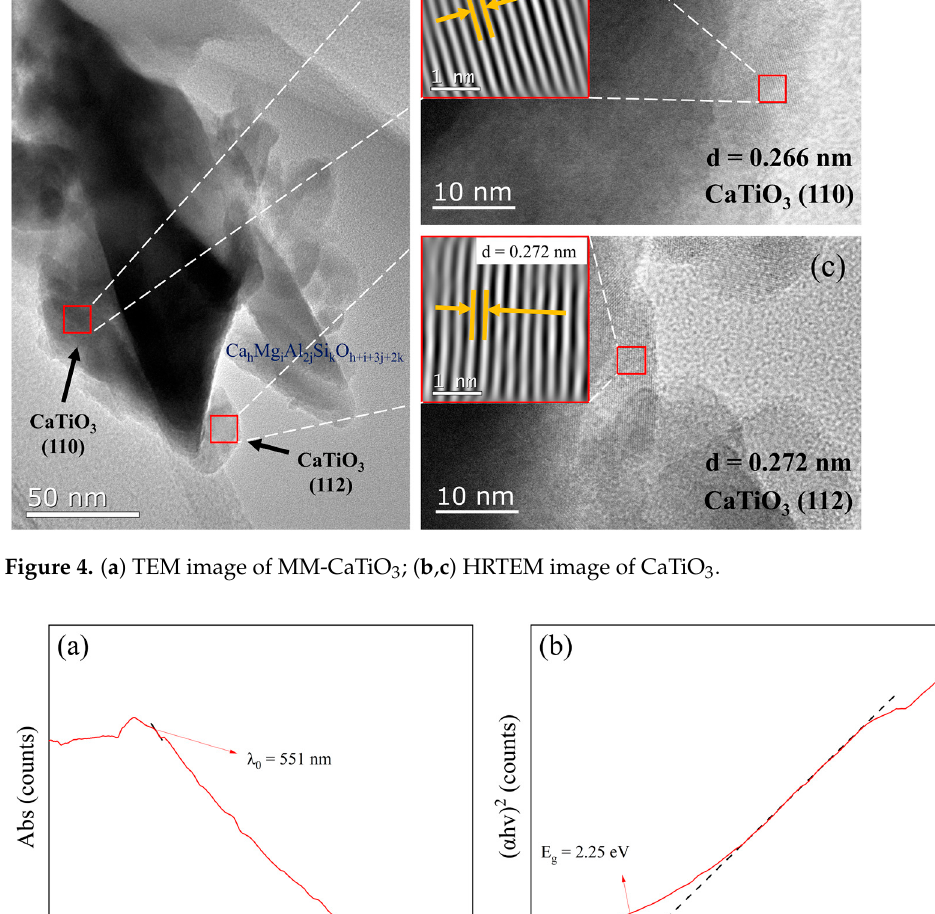
Figure 4. ( a ) TEM image of MM-CaTiO 3 ; ( b , c ) HRTEM image of CaTiO 3 .